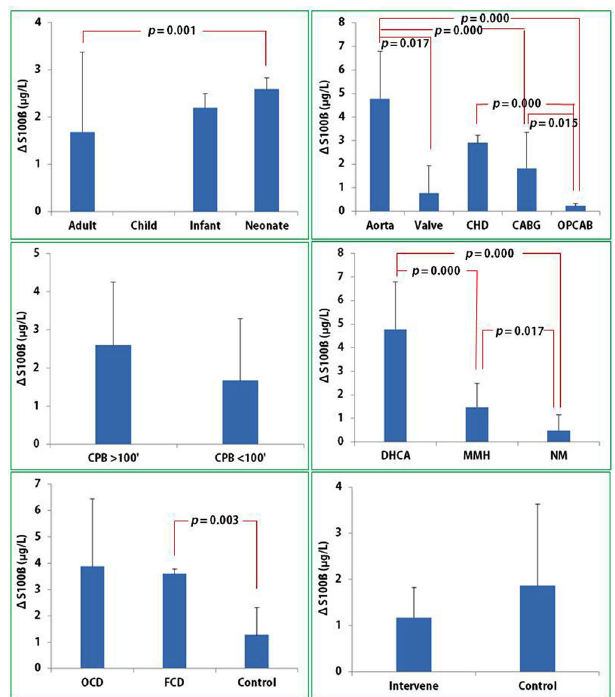
Fig. 6 - An inter-subgroup comparison of serum ΔS100ß at T CABG=Coronary artery bypass; CHD=Congenital heart defect; DHCA=Deep hypothermia circulatory arrest; FCD=Functional cerebral damage; MMH=Mild-moderate hypothermia; NM=Normothermia; OCD=Organic cerebral damage; OPCAB=Off- pump coronary artery bypass